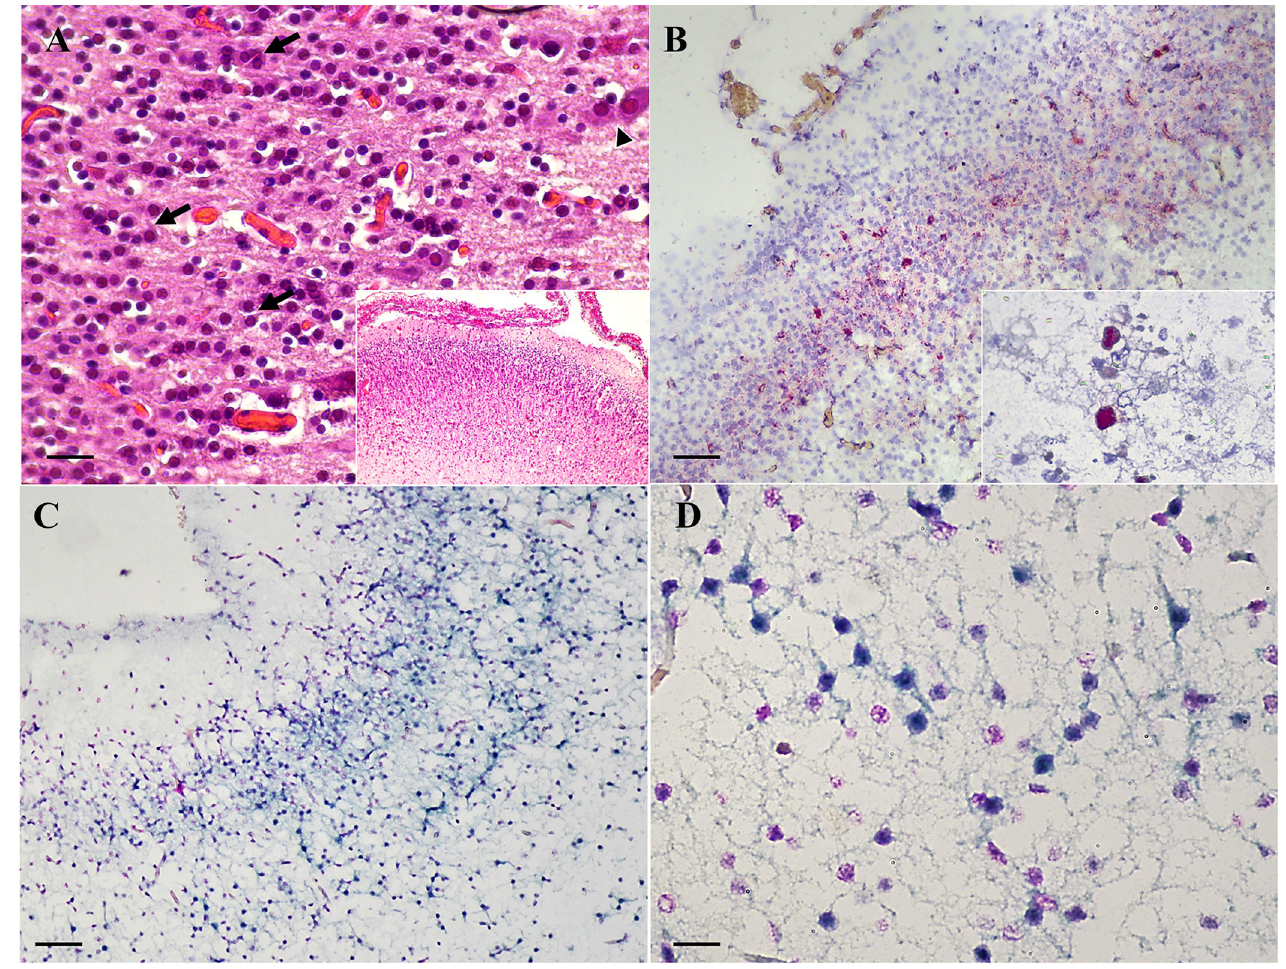
Fig 2. CBoV-2 infection in dog no. 240CP5. Photomicrographs demonstrate H&E staining (A) and CBoV-2 ISH (B–D) in brain. (A). Hypercellularity of the cortical plate and ventricular zone of the cerebrum (inset). Variable numbers of glial cells containing large, bright eosinophilic intranuclear inclusion-like material (arrows) and hypereosinophilic neurons (arrowhead). (B). Hybridization signals using a probe targeting NS1 of CBoV-2 were strong and localized in the nucleus of glial cells (red precipitates). The signals were strong and clearly observed in the glial cells containing intranuclear inclusion-like material (inset). Hematoxylin (pale blue) was used as a counterstain. (C) and (D). Nuclear hybridization signals using a probe targeting VP1 of CBoV-2 revealed diffuse staining patterns in many glial cells (dark blue green). Nuclear fast red (pink) was used as a counterstain. Bars indicate 25 μ m (A and D) and 120 μ m (B and